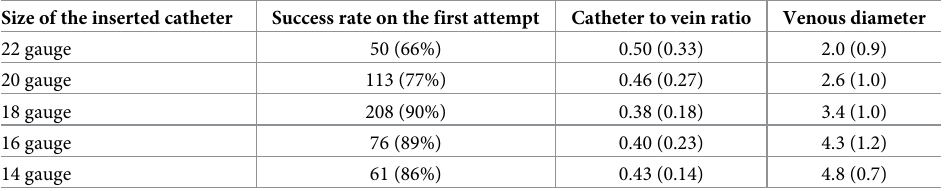
Success rate on the first attempt is represented as proportions (percentages). Catheter to vein ratio and venous diameter in millimeters are represented as median (interquartile range).